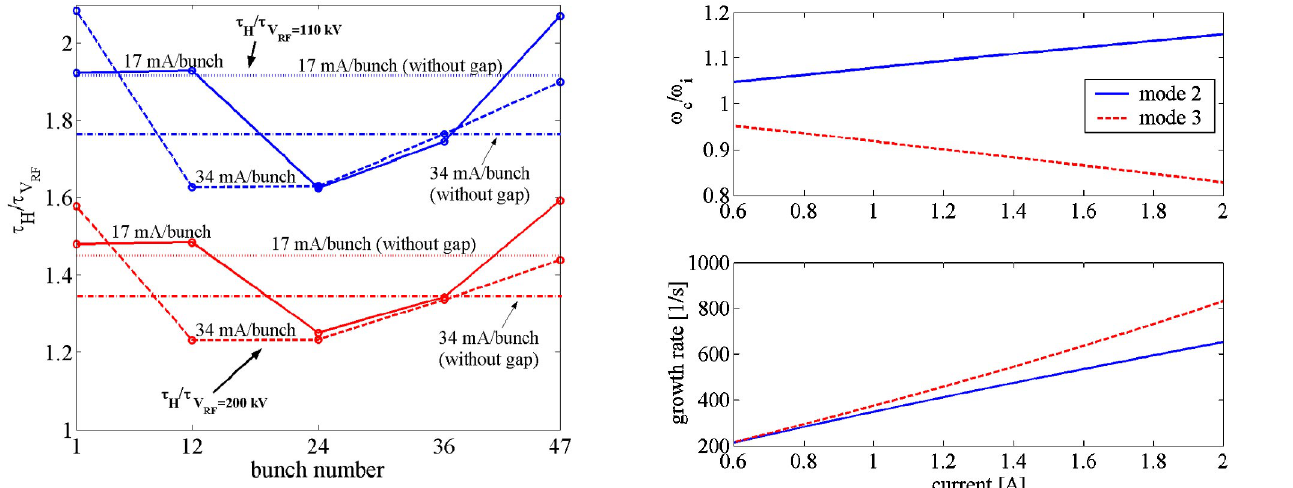
FIG. 15. (Color) Synchronous phase spread ( I 47 bunches) for various % n .